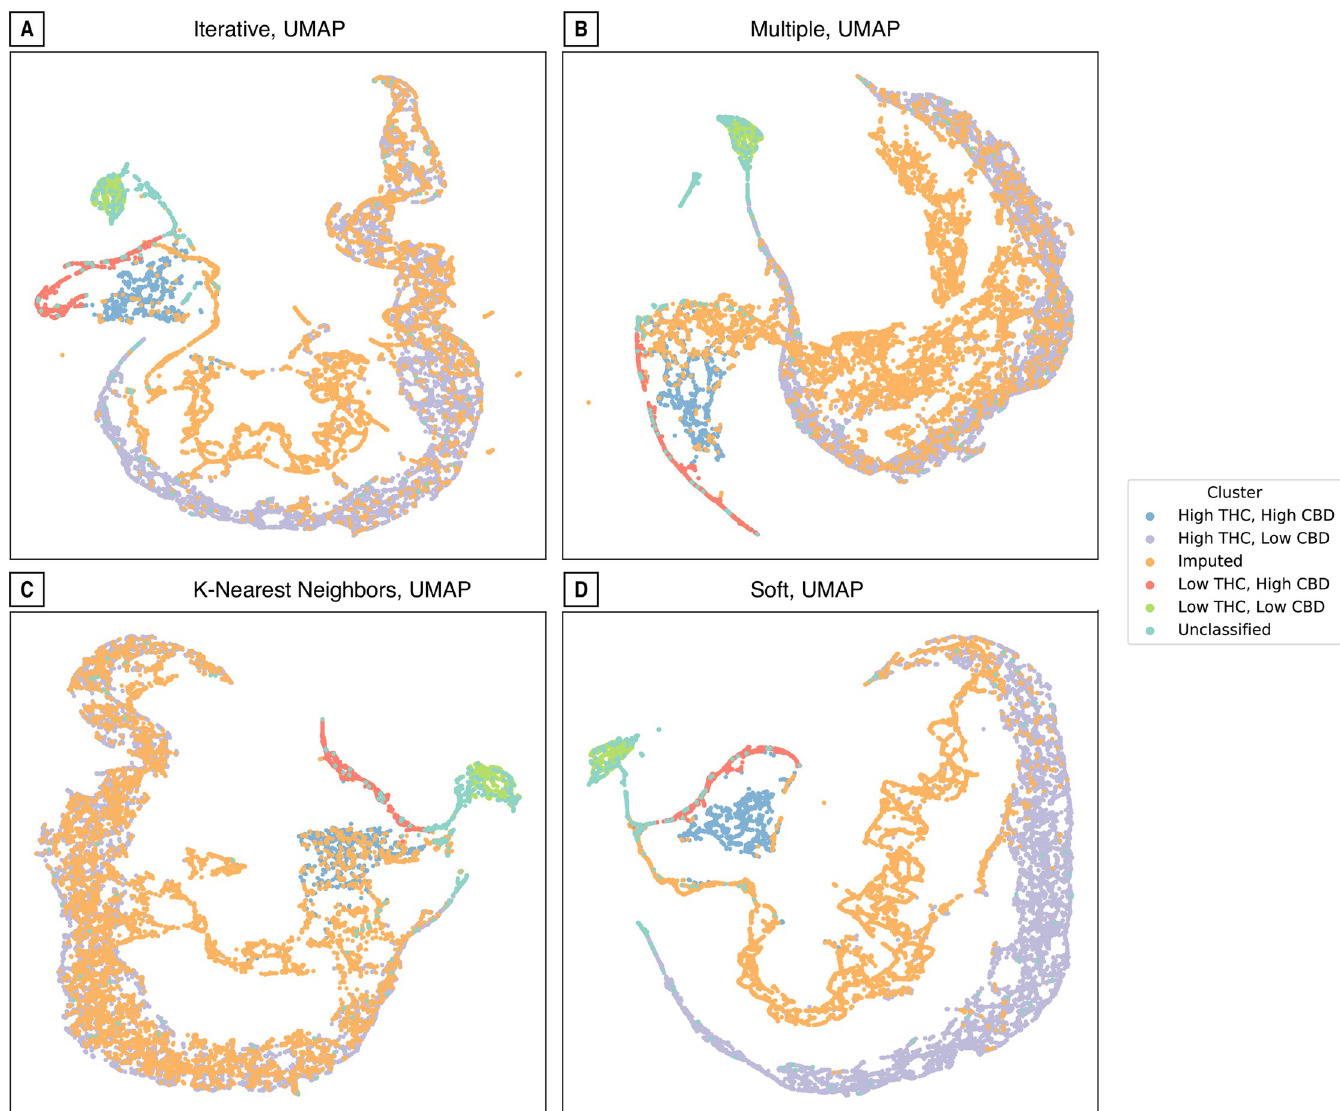
Fig 6. Visualization of imputed data by reducing data with uniform manifold approximation and projection (UMAP).